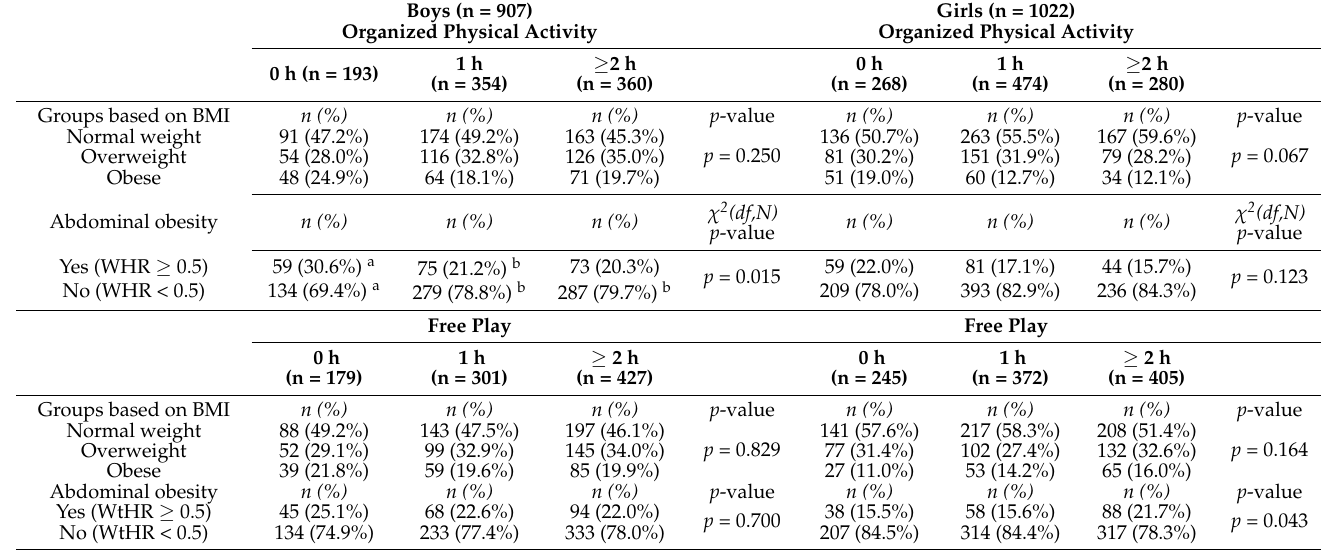
Table 2. Comparison of hours spent in organized physical activity and free play, based on BMI- and abdominal obesity groups analyzed by